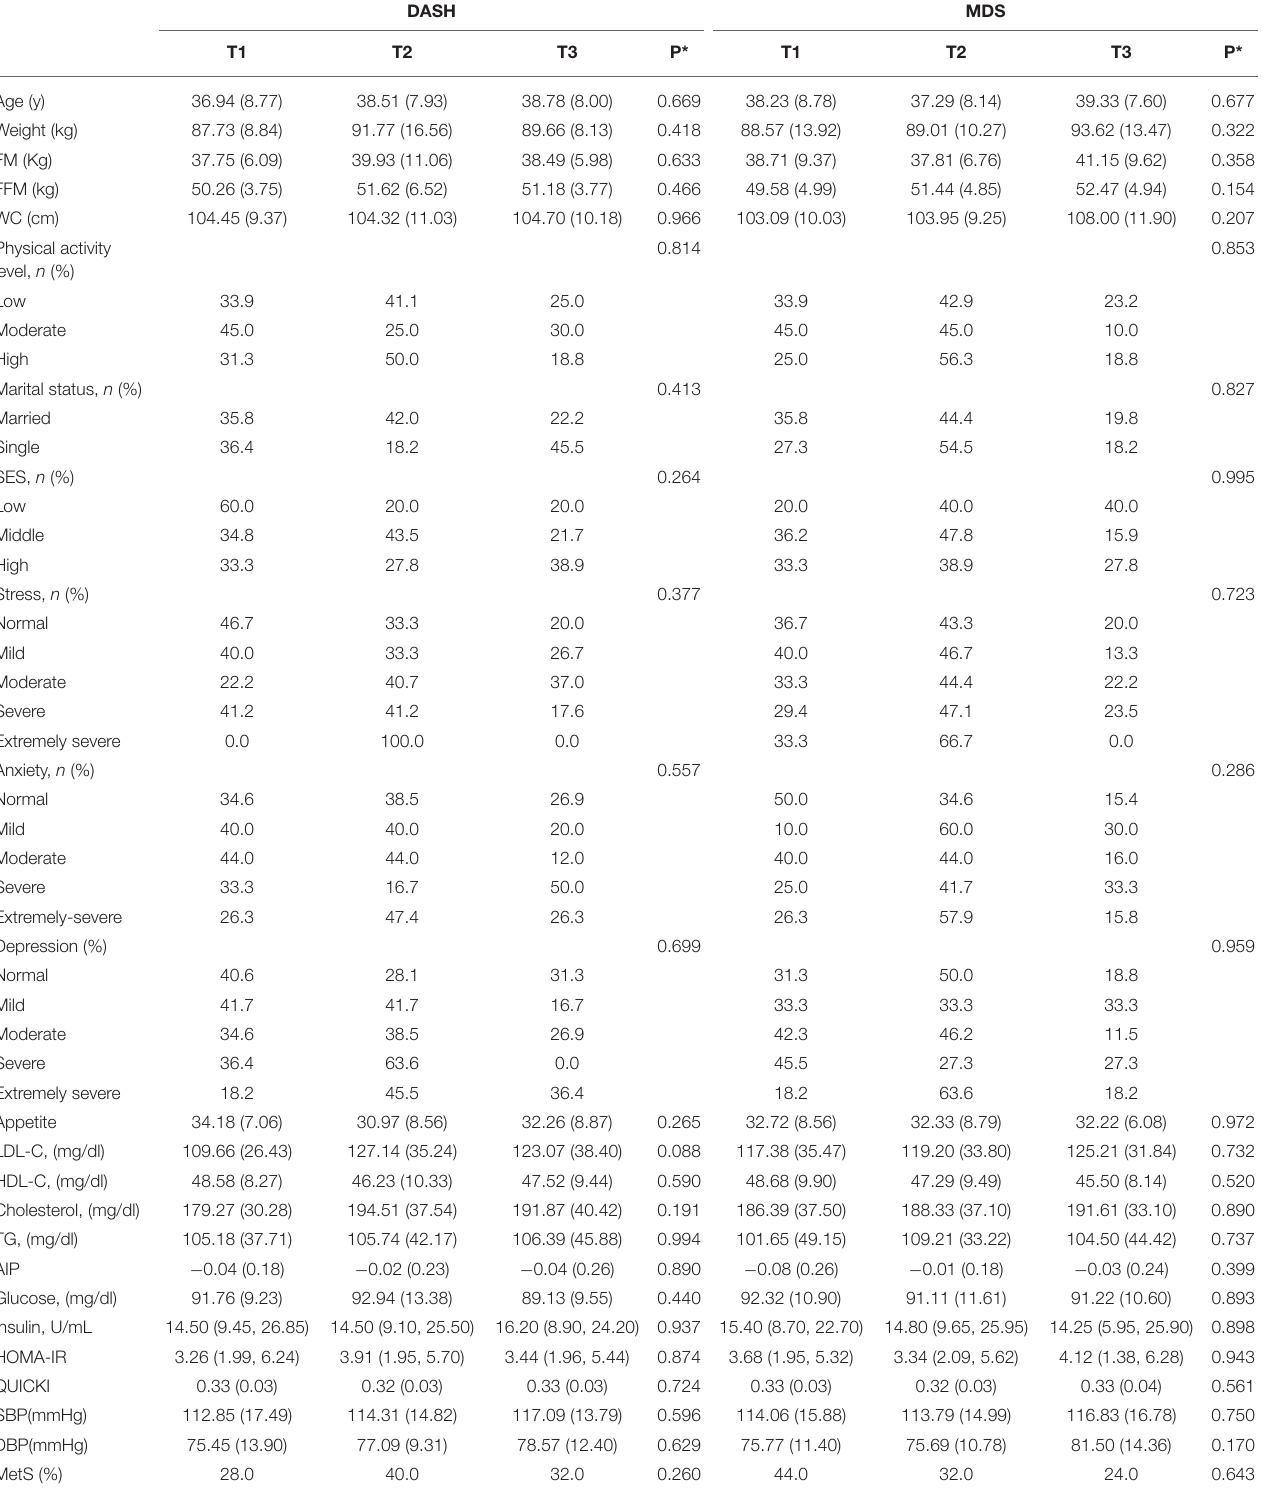
TABLE 4 | Socio-demographic and anthropometric characteristics and cardio-metabolic risk factors according to the tertiles of dietary quality indices in women.